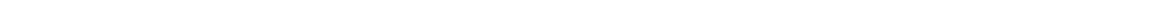
Fig. 3 Gene expression studies on LCNEC and SCLC. a The expression pro fi les of LCNEC and SCLC tumors were analyzed following the annotation and approach described in Fig. 2a. Expression values of genes identi fi ed by ClaNC (Methods section) are represented as a heatmap in which red and blue indicate high and low expression, respectively. Selected candidate genes are shown on the right. Dashed green lines indicate an expression pro fi le shared by LCNEC tumors with STK11 / KEAP1 alterations (type I LCNECs). b The signi fi cant enrichment of differentially expressed genes and signaling pathways are displayed for type I LCNECs and type II LCNECs. P < 0.0001 (Methods section); * some SCLC tumors that co-clustered with type II LCNECs were included in this analysis. Key candidate genes are highlighted in bold. c , d Expression values for c the key neuroendocrine differentiation markers SYP (synaptophysin) and CHGA (chromogranin A) (scatter plot), and d NOTCH pathways genes (box plots: median and interquartile range, whiskers: min – max values). e Signi fi cant enrichment of differentially expressed genes and signaling pathways was analyzed for class I and II vs class III and IV tumor samples; P < 0.0001 (Methods section). f Expression values of SOX1 , ELAVL3 , and ELAVL4 are plotted for the clustering classes and other lung cancer subtypes (box plots: median and interquartile range, whiskers: min – max values). Q < 0.05 (#), SAM (Supplementary Dataset 12); P < 0.01 (**) Mann – Whitney U